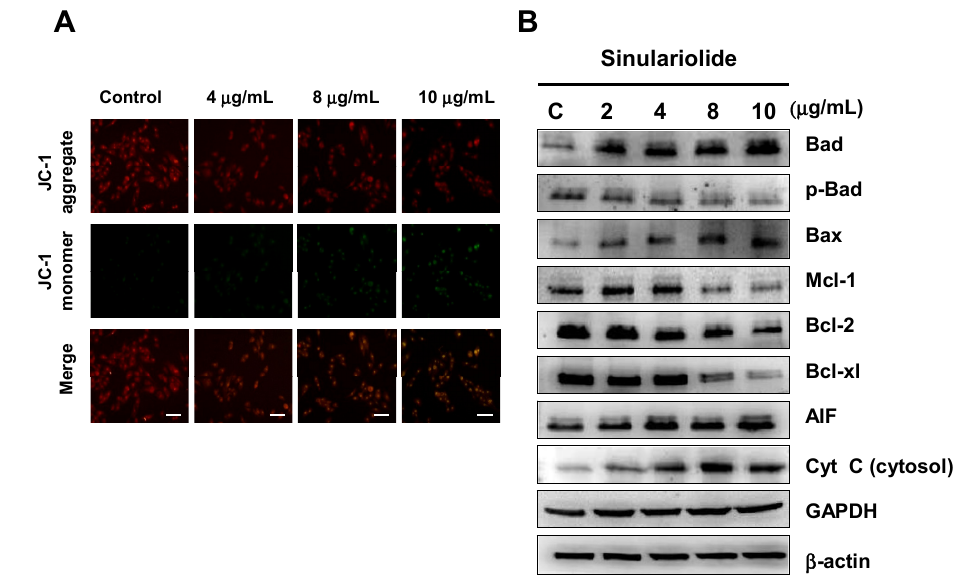
Figure 4. Sinulariolide induced mitochondrial membrane depolarization in the HA22T cells. ( A ) Cells were treated as indicated, stained with JC-1 dye, incubated with cells for 20 min at 37 °C, 5% CO and imaged under fluorescence microscope at the emission wavelength 2 of 580 nm (red, upper panels) and 530 nm (green, lower panels). Scale bars = 50 μ m. ( B ) Western blotting data showed the changes of Bax, Bad, p-Bad, Bcl-2, Bcl-xL, Mcl-1, cytosolic cytochrome c , and AIF expression in HA22T cells treated with different concentrations of sinulariolide. β -actin was used as the cytosol marker internal control. GAPDH was used as the mitochondrial marker internal